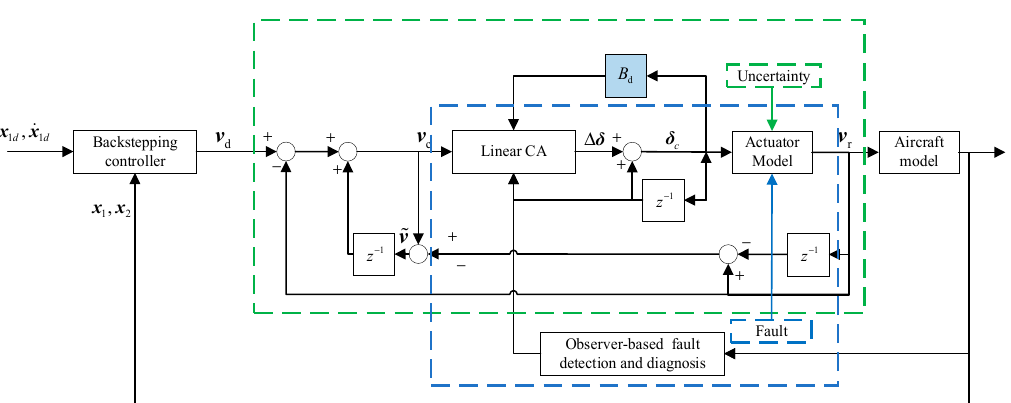
Figure 1. Fault-tolerant attitude control incorporating reconfiguration control allocation scheme.